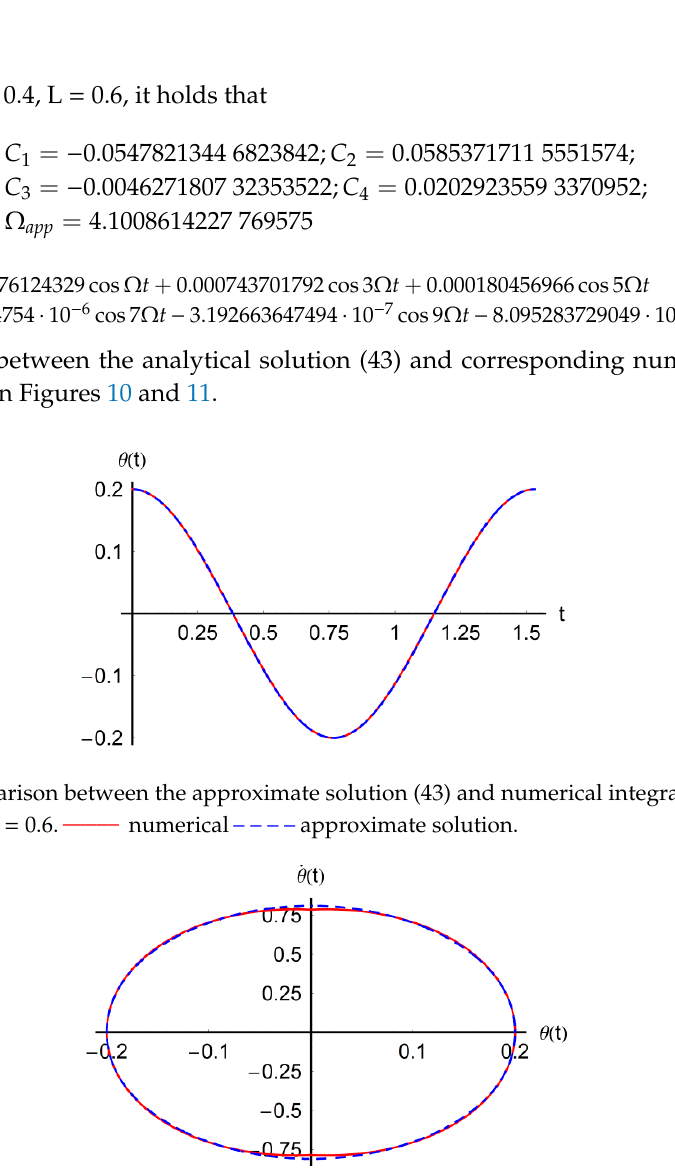
Figure 21. Phase plane for A = 0.4, L = 0.6. Figure 11. Phase plane for A = 0.2, a = 0.4, L = 0.6. _____ numerical_ _ _ _approximate solution (43). Figure 11. Phase plane for A = 0.2, a = 0.4, L = 0.6.